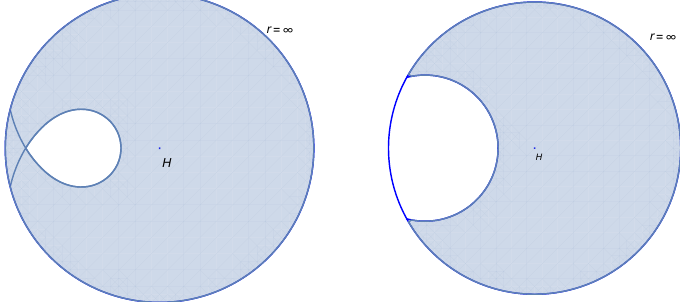
Figure 8 . Cases ( IIA +) ; ( IIB +) have (cid:11) e is positive at r min but negative at large r . The change of sign means that t Ee has a maximum, and the solution must take one of the forms shown. Since (cid:11) e ( r min ) > 0 requires us to keep the (unshaded) piece of the solution containing the larger r side of the wall at r min , any point with t Ee = 0 and r 6 = r min would yield a self-intersection (left). Avoiding such self-intersections (right) thus requires t Ee > 0 for r > r min along one entire branch of (2.8) with t Ee < 0 on the